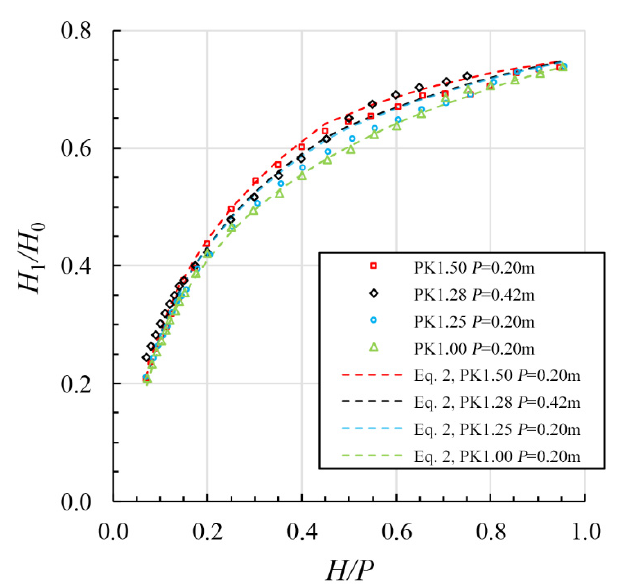
Figure 10. Observed and predicted values of relative residual energy using Equation (2).